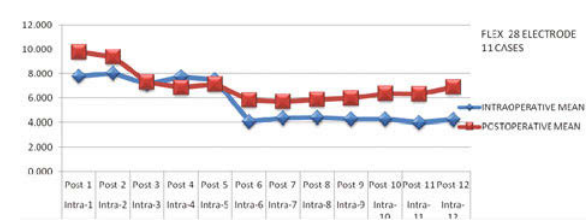
Mean of each active electrode impedance measured in patients intraoperatively and1 month postoperatively using Flex 28 electrode.